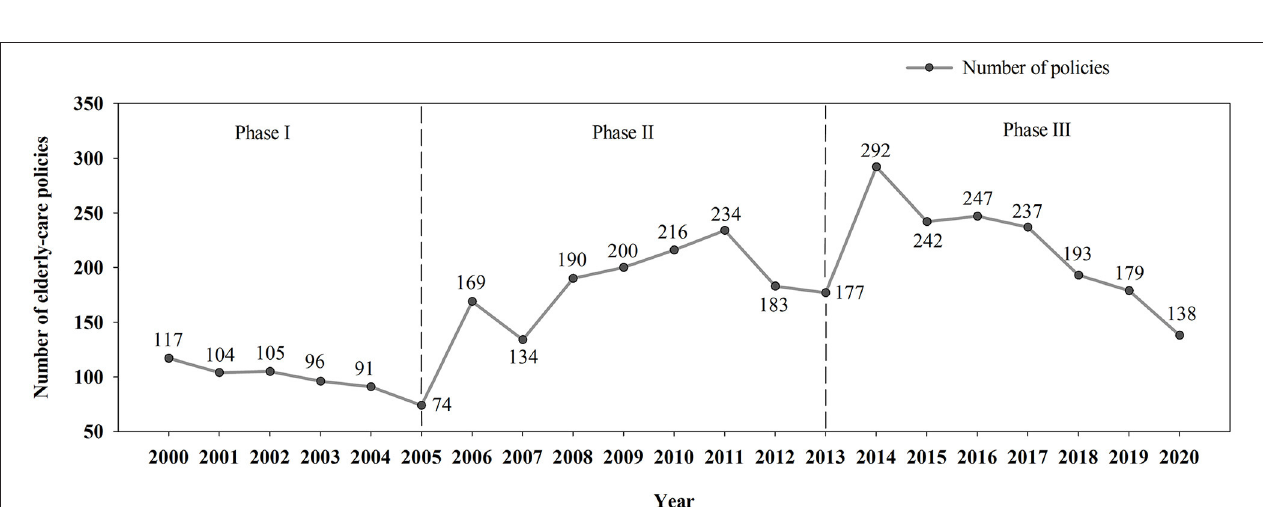
FIGURE 3 | Annual number of the local elderly care policies promulgated in China, 2000–2020.